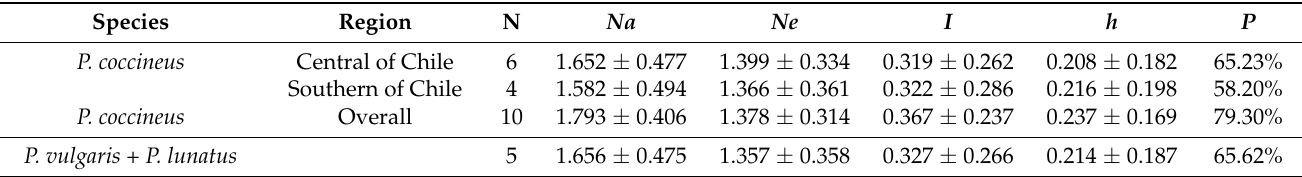
Table 5. Genetic diversity indexes of the different lines of Phaseolus evaluated in this study. Species Region